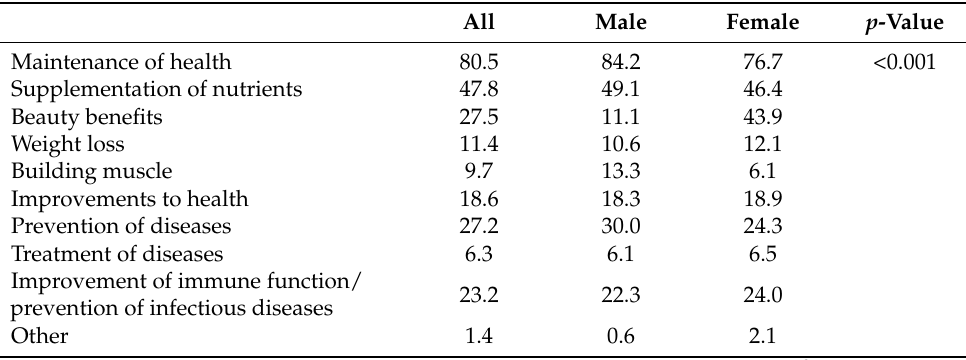
Table 9. Purpose of use of vitamin-fortified food/vitamin supplements.